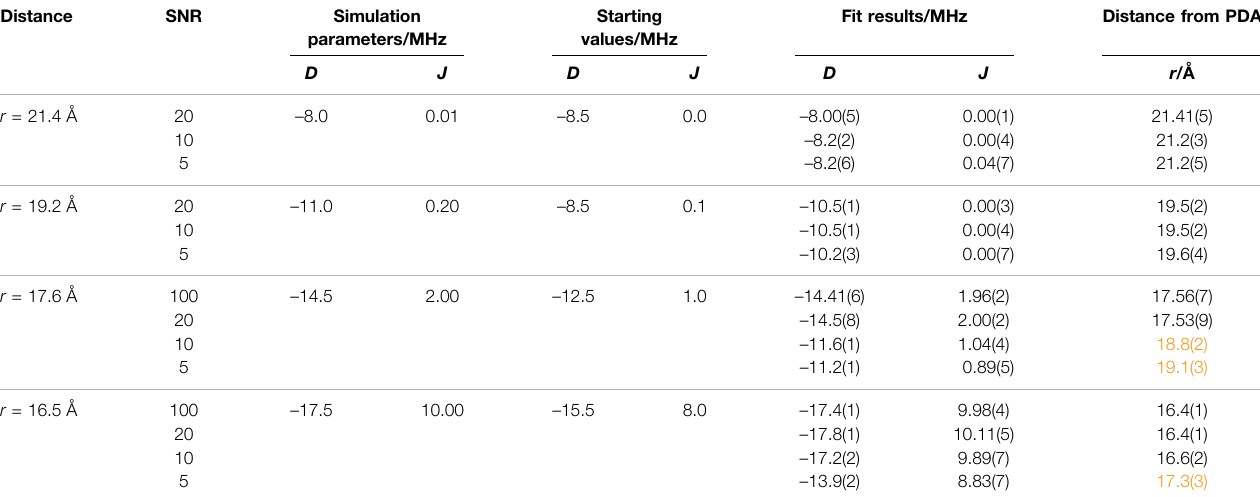
TABLE 3 | Comparisons of calculated OOP-ESEEM time traces using different D and J value combinations with results from numerical simulations using Eq. 5 . Starting valuesforleast-squares fi ttingswere T d =0.25 µsand H =1.Thestartingvaluesfor D and J were15%offthetheoreticalvalues. D , J , T d, and H wereallowedbythe fi tting routine to be varied in the intervals – 20 MHz ≤ D ≤ 0, 0 ≤ J ≤ 15 MHz, 0 ≤ T d ≤ 10 µs, and 0 ≤ H < ∞ . The distance r was calculated using Eq. 3 . Obtained distances with increased error margin ( > 10%) or incorrect values are highlighted in